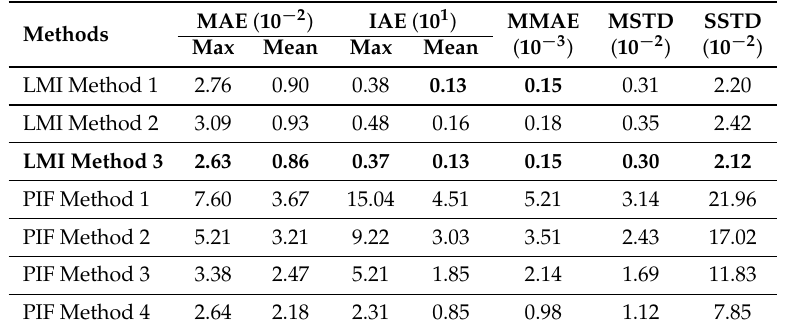
Figure 3. Simulation results for step change of 0.2 m 3 /s in the non-lineal canal model for the proportional-integral filtered (PIF) methods [51]: ( a ) Method 1 of PIF method; ( b ) Method 2 of PIF method; (c) Method 3 of PIF method; ( d ) Method 4 of PIF method. Table 3. Non-linear model simulation key performance indicators (KPIs): maximum absolute error (MAE), integral of absolute magnitude of error (IAE), mean of mean absolute error (MMAE), mean of standard deviations (MSTD), and sum of standard deviations (SSTD).